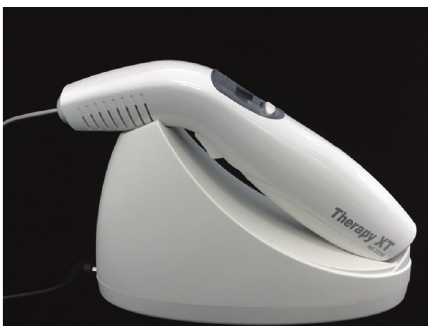
Figure 10: Laser unit used ( 𝜆 = 660nm) and optical fiber (Therapy XT-DMC, S˜ao Carlos, SP, Brazil).